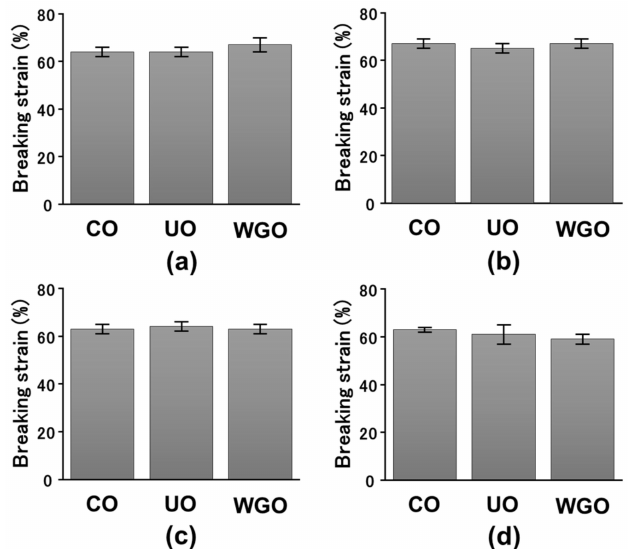
Figure 2. Breaking strain in okara–soybean protein isolate (SPI) gels. ( a ), 3% okara–SPI gels; ( b ), 5% okara–SPI gels; ( c ), 10% okara–SPI gels; ( d ), 15% okara–SPI gels. CO, control SPI gel; UO, wet- type grinder (WG)-untreated okara–SPI gel; WGO, WG-treated okara–SPI gel. SPI concentrations and WG-untreated and treated okara in 3%, 5%, 10%, and 15% okara–SPI gels are indicated in the Figure 1